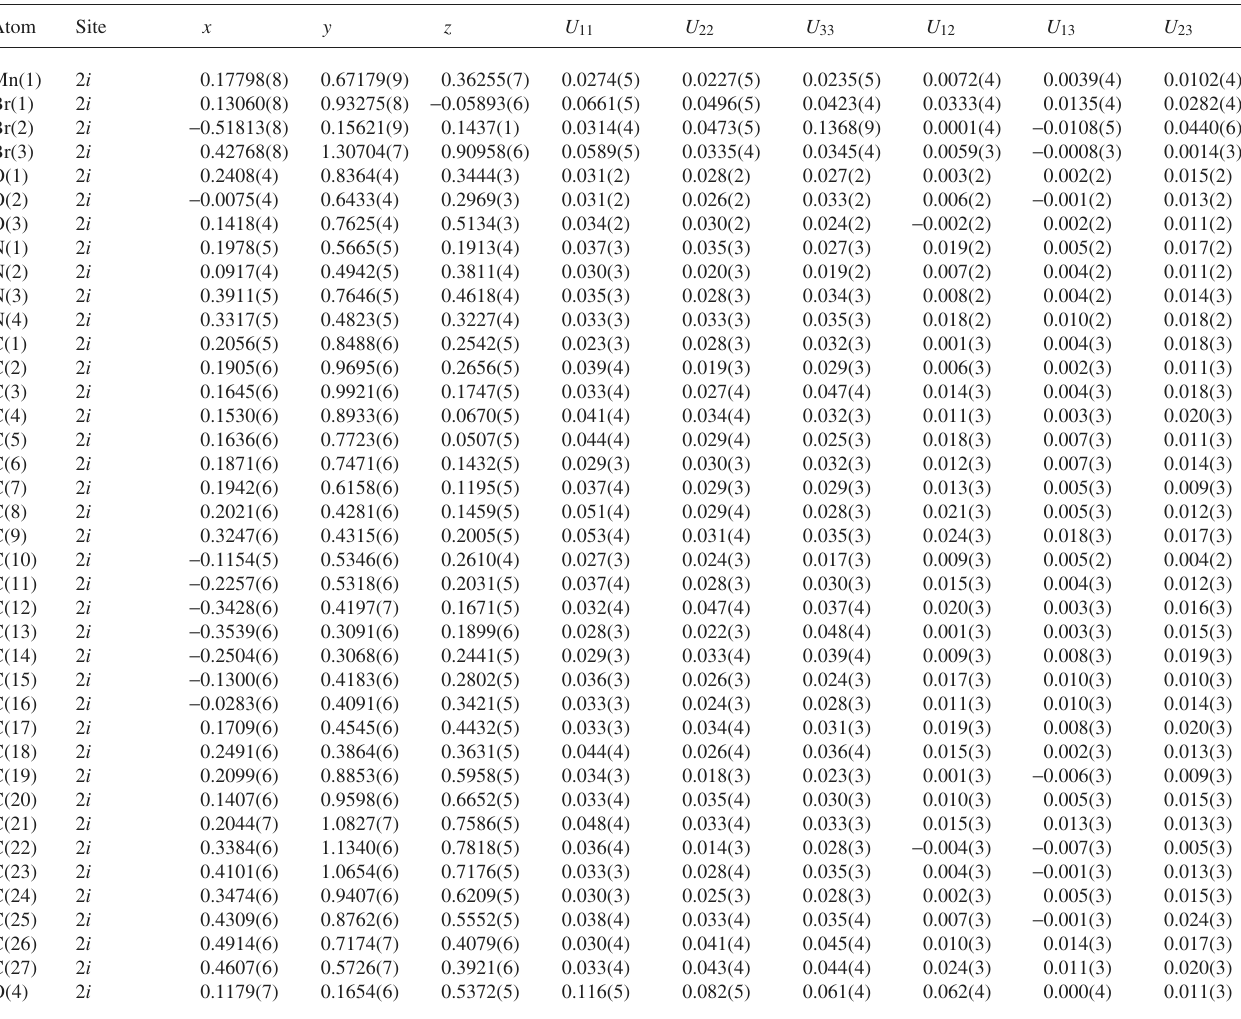
Table 3. Atomic coordinates and displacement parameters (in Å 2 )